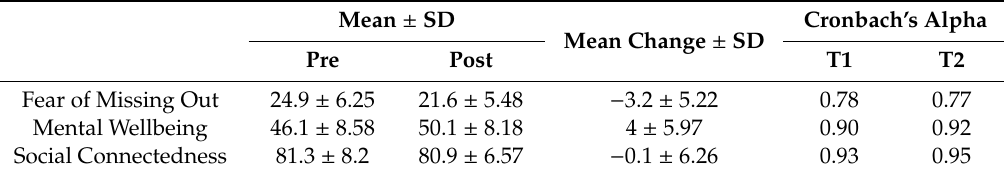
Table 2. Means and standard deviations for each dependent variable before abstinence and after abstinence, including their change score and Cronbach’s alpha